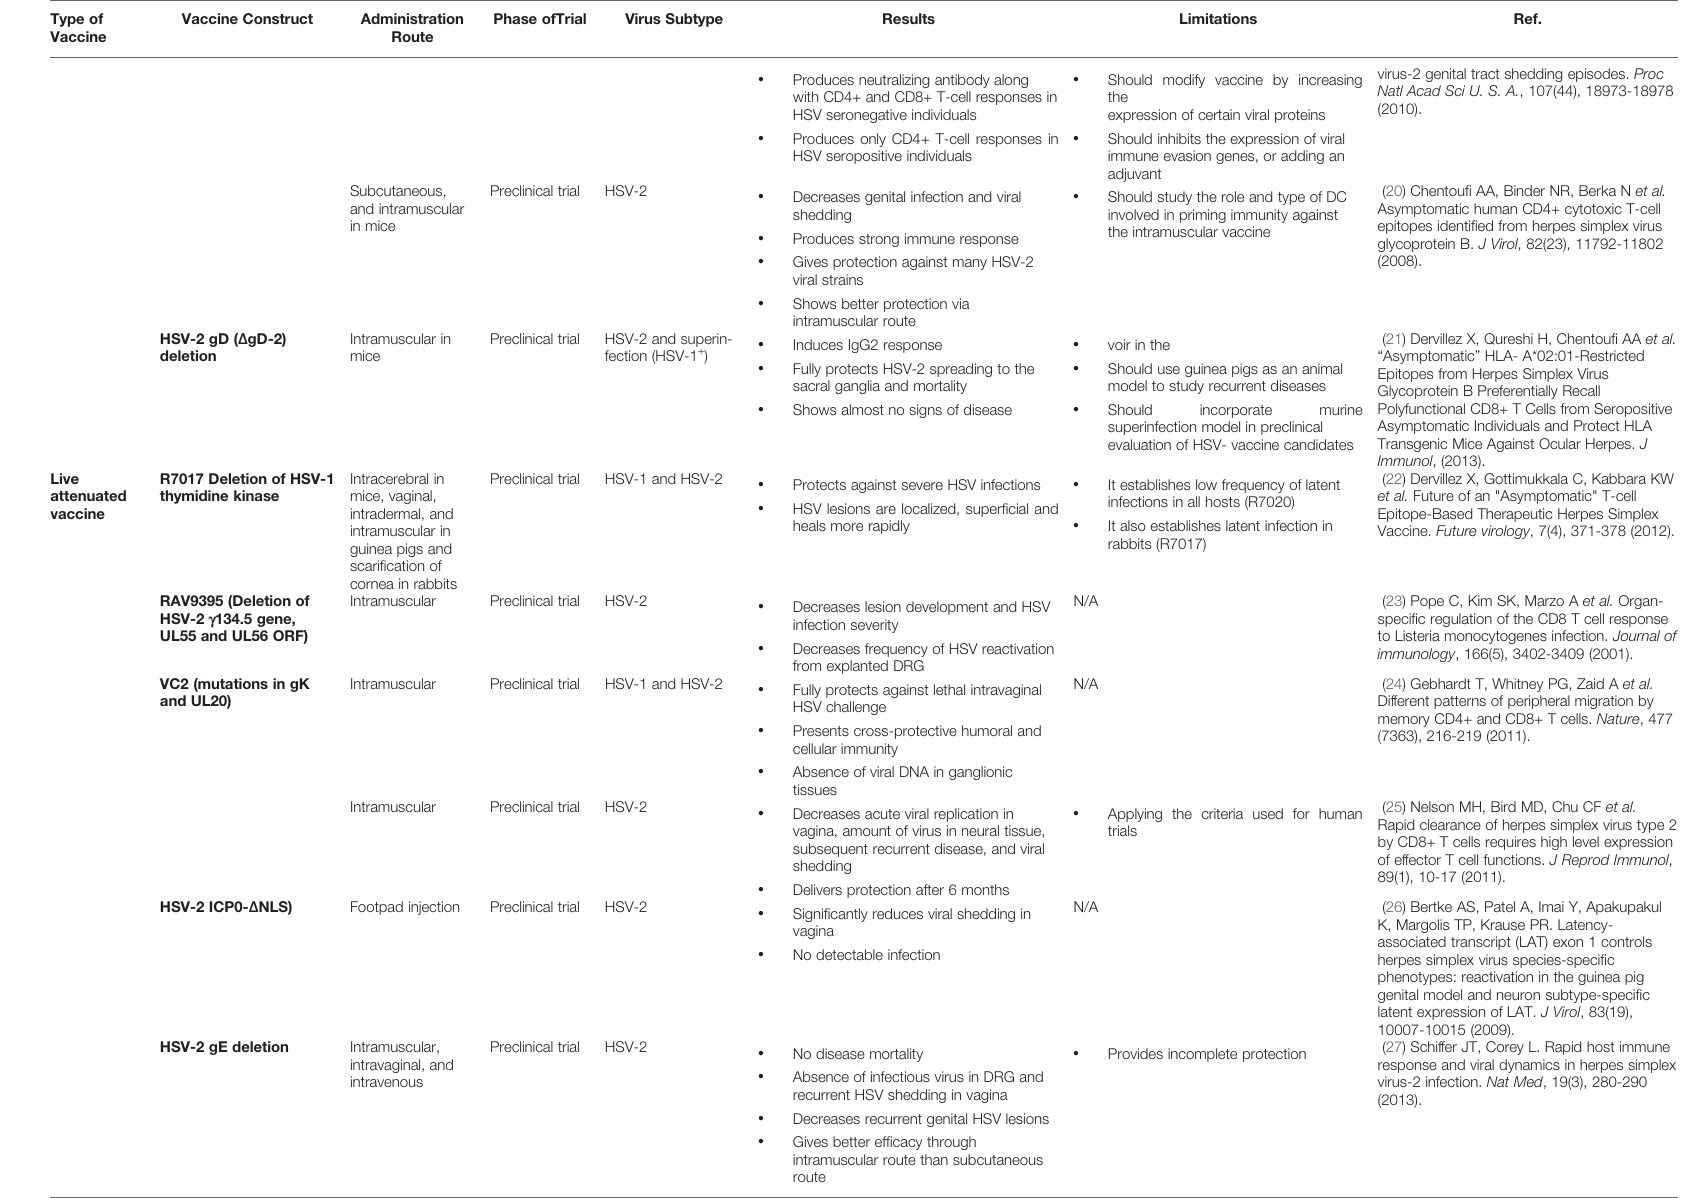
Transgenic Mice Against Ocular Herpes. J Immunol ,